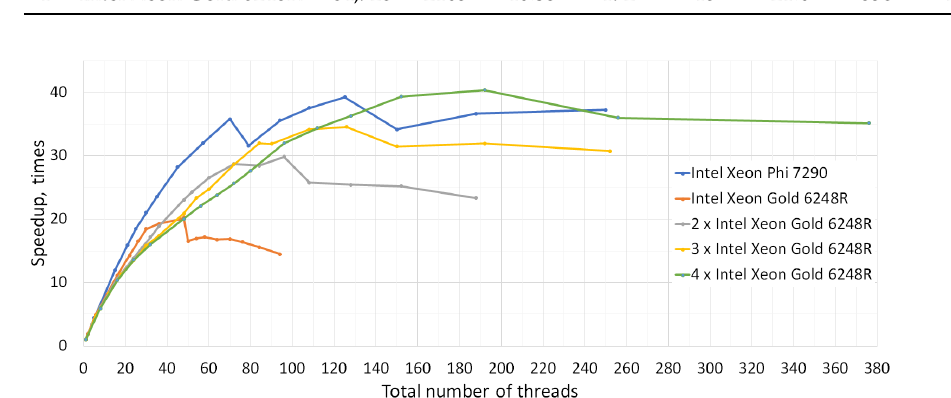
Figure 5. Speedup of inverse problem solution on different hardware configurations. The best values are achieved with the numbers of threads equal to the number of processor cores (for Intel Xeon Phi node, twice the number of cores).